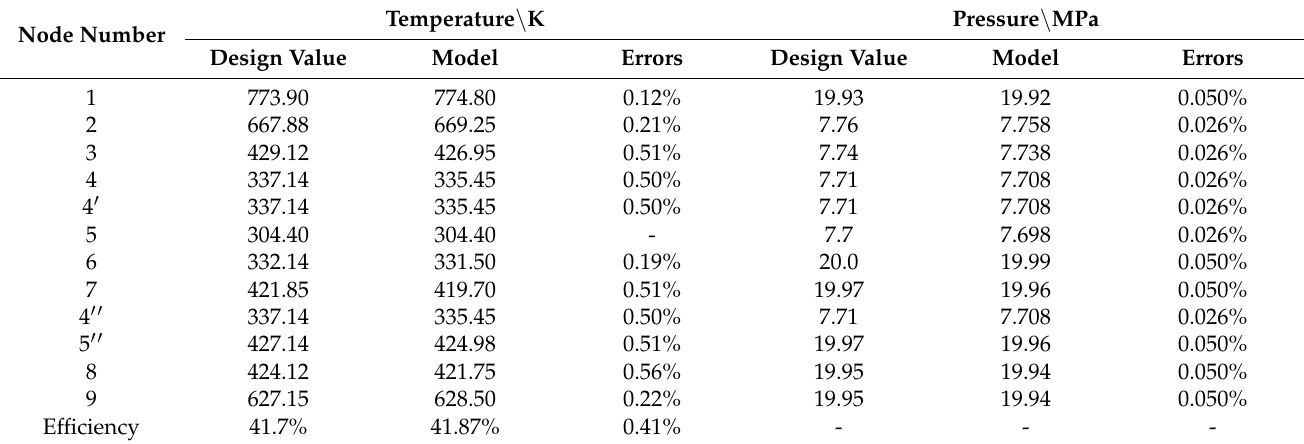
Table 6. Verification of the operation results of the SCO 2 recompression cycle design